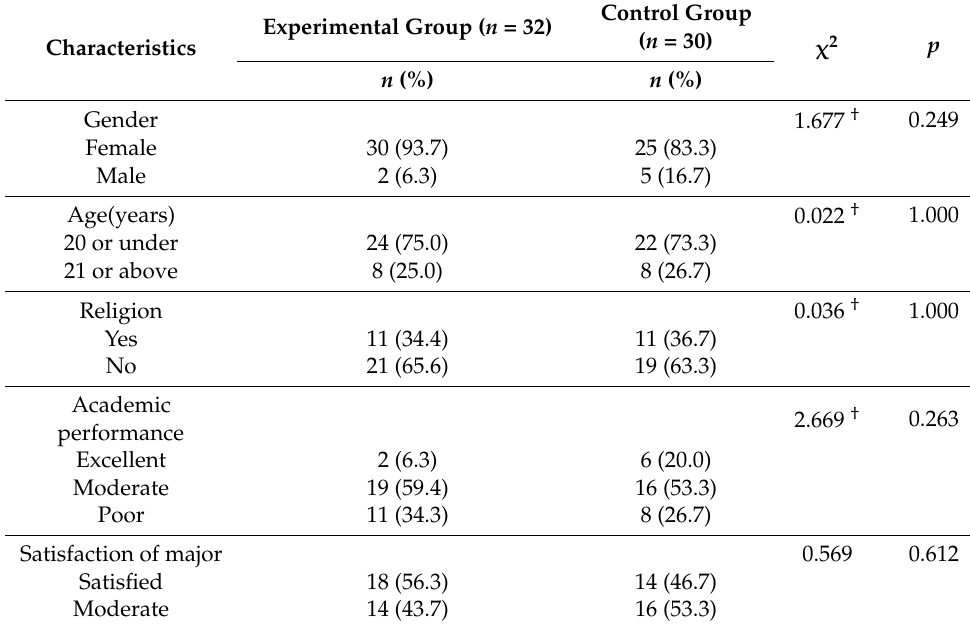
Table 2. Homogeneity of general characteristics between the control and experimental group ( N = 62).